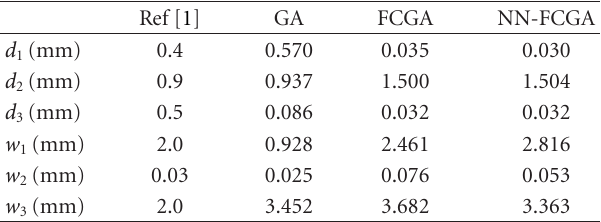
Figure 4: Best fitness plotted as a function of number of generations for the GA, FCGA, and NN-FCGA. Table 1: Optimized design parameters of the low-pass planar filter for the GA, FGGA, and